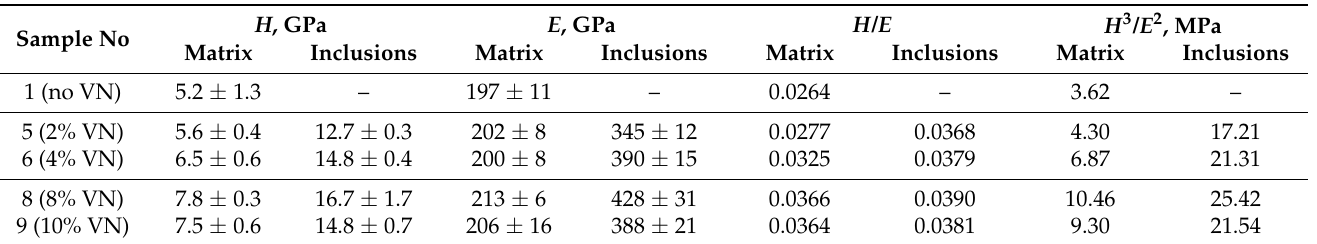
Table 2. Mechanical characteristics of sintered matrix material 51Fe–32Cu–9Ni–8Sn and of nano-VN inclusions in it.